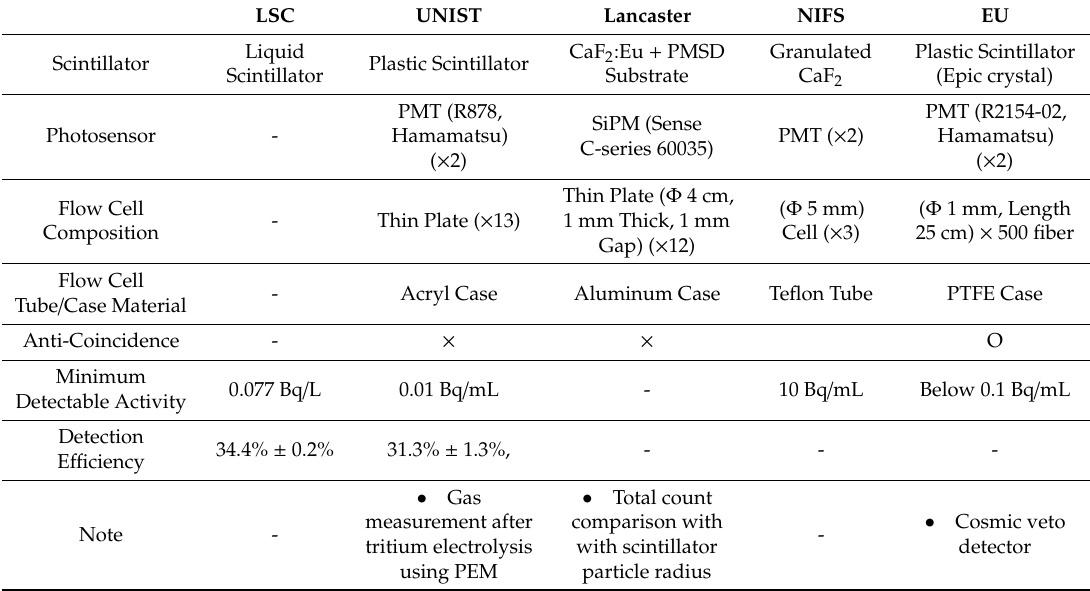
Table 19. Flow cell